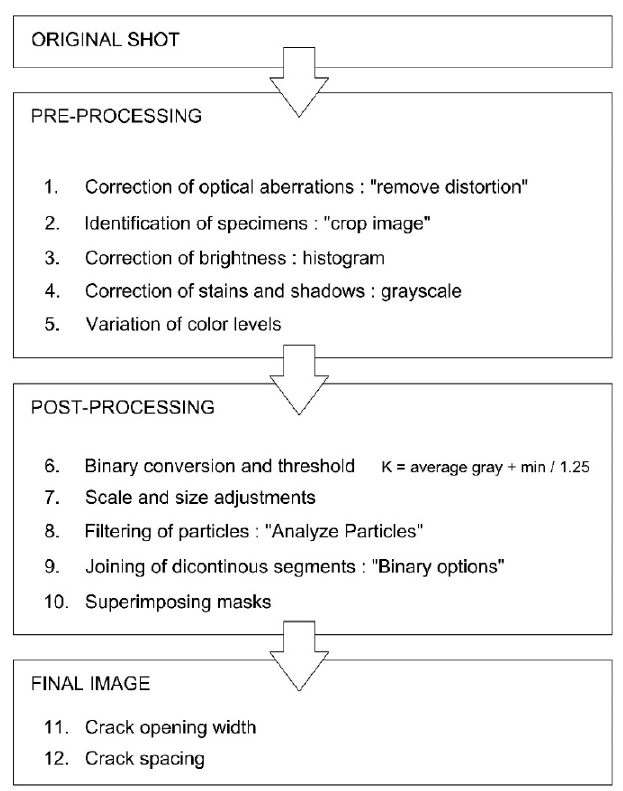
Figure 19. Proposed image-based processing method.